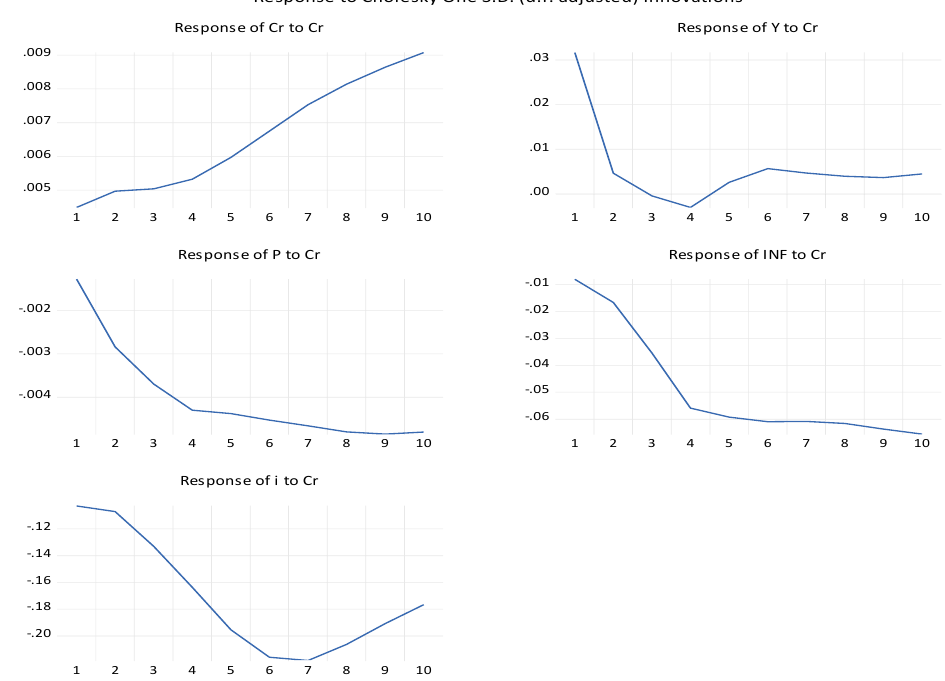
Figure 3. The response of mortgage credit volume to housing demand in Istanbul, Turkey.